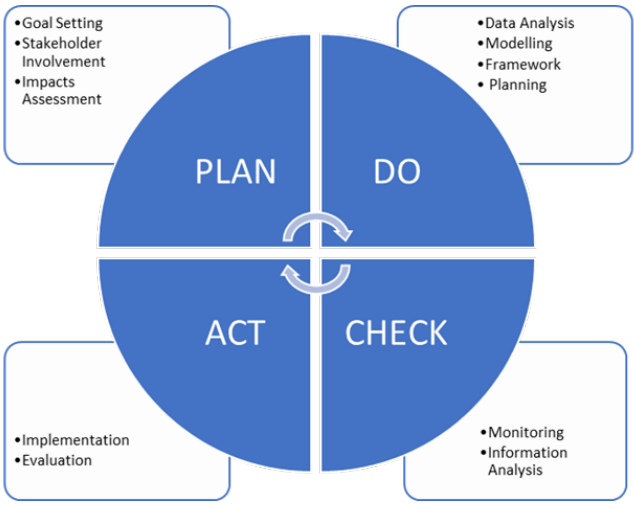
Figure 7. Total Water Management—the planning